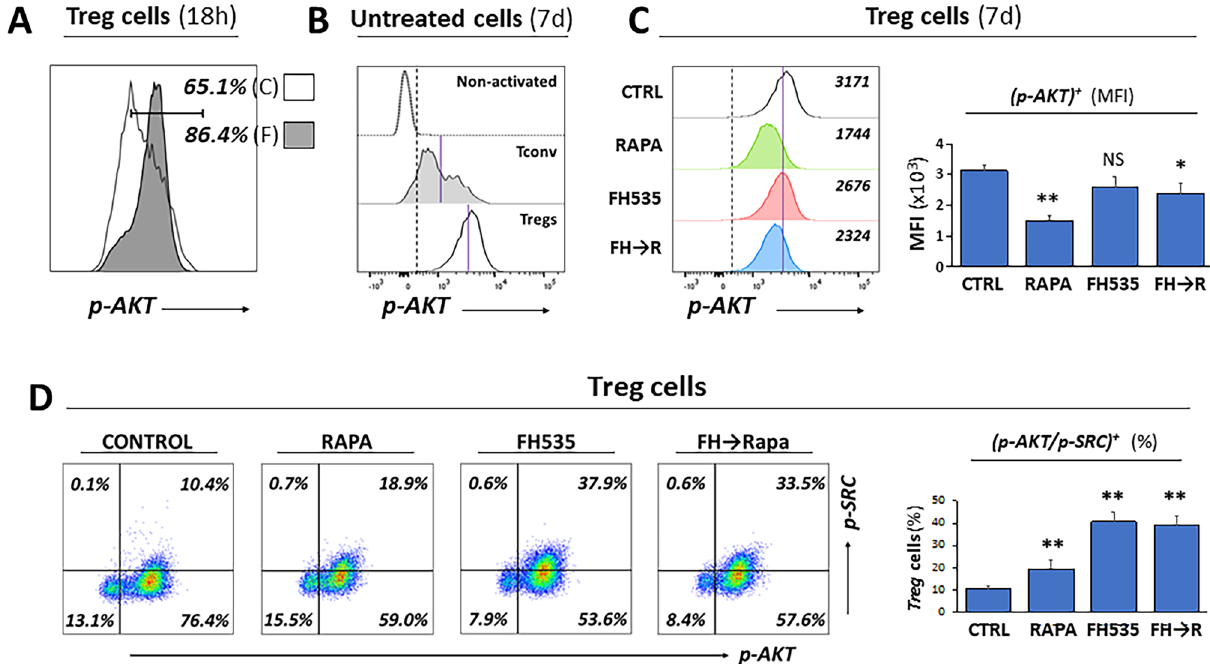
Figure 5. Overactivation of AKT/mTOR signaling by FH535 treatment in Treg cells is partially mitigated after the sequential addition of Rapamycin (FH535 → Rapa). ( A ) Representative histogram panel showing the short- term (18-h) enhancing effect of FH535 (F, filled profile) overlayered with untreated control (C, empty profile) Treg cells. Results are shown as percentages of p-AKT + cells. ( B ) p-AKT expression profiles in non-activated (CD25 − ), activated (CD25 + ) Tconv and Treg cells are shown as offset histogram panels defining common threshold values for p-AKT + (dashed vertical line) and the specific GeoMFI (blue line). Worth noting the higher expression of p-AKT in Treg cells compared to Tconv. ( C ) Representative offset histogram data analysis and pooled graph of 4 individual experiments (mean ± SD of GeoMFI values) of p-AKT expression in Treg cells exposed to the different treatments during seven days. Threshold of positive p-AKT expression (dotted line) and GeoMFI value of control treatment (blue line) are shown as reference. ( D ) Representative dual dot-plot analysis corresponding to the expression of p-AKT and p-SRC kinase (activated form, phosphorylated at Y 416 ) in Treg cells. The percentages of positive cells for each condition are indicated in corresponding panels. Column graph of pooled data analysis illustrates mean percentage ± SD of double positive p-AKT/p-SRC Treg cells from 4 individual